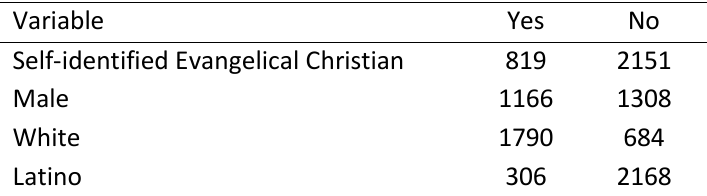
Table A2. Frequency table of categorical variables.